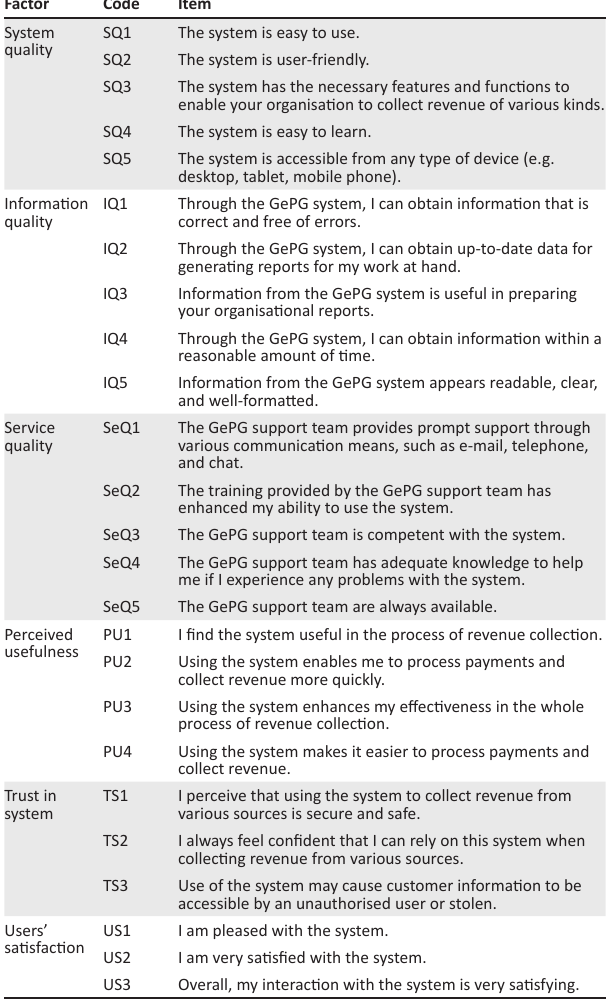
TABLE 1: The items for each factor. Factor